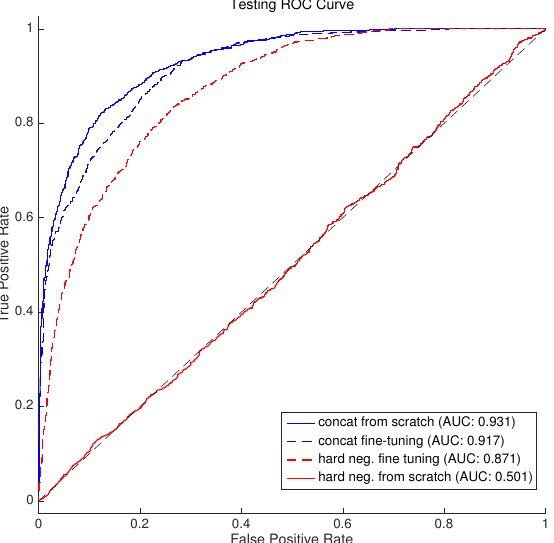
Figure 9. The receive operator characteristic (ROC) curves for various approaches for using generated hard-negatives in the training of a SAR-optical matching network. From these various experiments, it can be seen that including the generated hard-negatives into the original dataset leads to a matching network with better performance than using only generated negative samples for